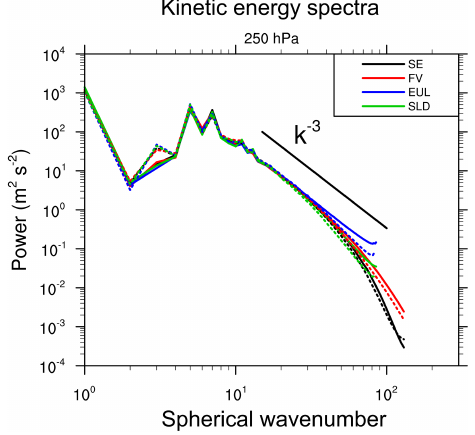
Figure 11. 250hPa kinetic energy spectra for MITC (solid lines) and APS (dashed lines) simulations with SE (black), FV (red), EUL (blue), and SLD (green). The slopes can be compared to the theo- retical k − 3